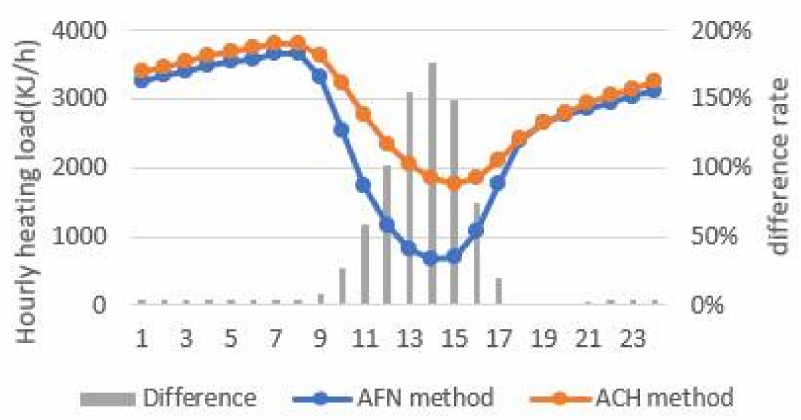
Figure 7. Comparison of the results of the AFN model and ACH model for a heating design day. Comparing the difference in heating load between the two models during the heating design day indicated a 180% higher heat loss for the model using the ACH method at peak times than the model using AFN, and a 13% higher heat loss on a daily average. As shown in Figure 8, the cooling design day has a similar cooling load at night. However, the heat gain per hour in the baseline model using the AFN method was 20% higher than that in the model using the ACH method as the balcony air temperature increases due to solar radiation in the daytime. In the case of the ACH method, heat transfer from the balcony to the residential area only occurs via conduction. However, in the case of the AFN method, heat transfer occurs in addition to conduction due to the airflow between the balcony and the residential area. Thus, a higher heat gain takes place in summer and less heat is lost during winter under the model that uses the AFN